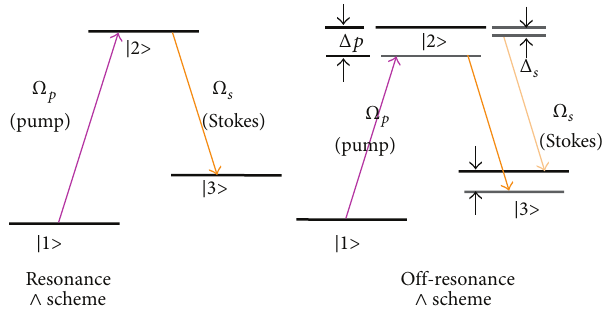
Figure 5: Energy-level diagram of three states in a molecule or atom. 𝜔 𝑝 represents the angular frequency of the pump photons which couple states |1⟩ and |2⟩ . 𝜔 𝑠 represents the angular frequency of the Stokes photons which couple states |2⟩ and |3⟩ . In the off- resonance diagram the photon energies are detuned by an amount Δ Δ 𝑝 for the pump photons, and 𝑠 for the Stokes photons yielding a two-photon detuning of 𝛿 = Δ 𝑝 − Δ 𝑠 for the combination. The heavy black horizontal lines correspond to energy states in the atom or molecule. The grey lines, which are present for illustration only, do not correspond to energy